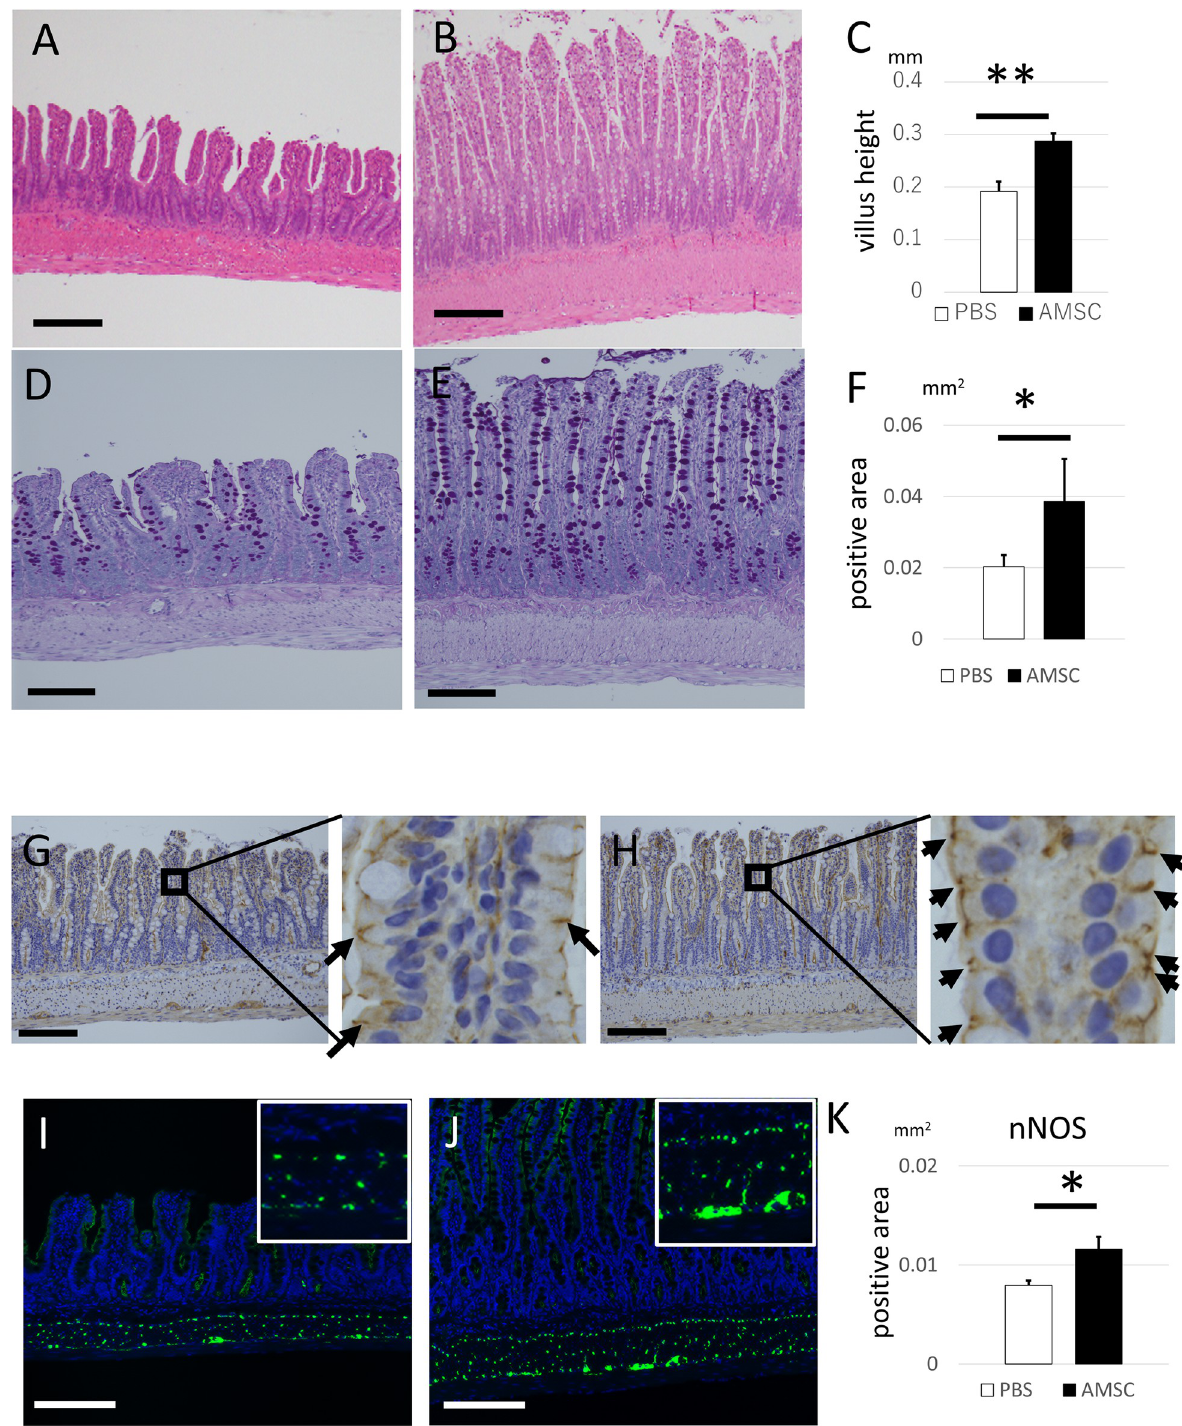
Fig 4. Administration of AMSCs improved intestinal structures, mucus secretion, tight junction, and peristalsis is reversed by spinal-origin neurotransmitter. (A–C) The ileum in PBS group (A) was more atrophic than those in the AMSC group (B) (magnification, × 100; scale bar: 200 μ m), and the villus height in the AMSC group was significantly superior to those in the PBS group (C, P = 0.0118). (D–F) The ability to produce mucus was evaluated via PAS staining 3 days after SCI. The ileum in PBS group (D) had fewer goblet cells containing intestinal mucus than those in the AMSC group (E) (magnification, × 100; scale bar: 200 μ m). The PAS-positive area in the AMSC group was significantly larger than that in the PBS group. (F; P = 0.0306). (G–H) The permeability between the intestinal epithelial cells was evaluated via IHC staining using the